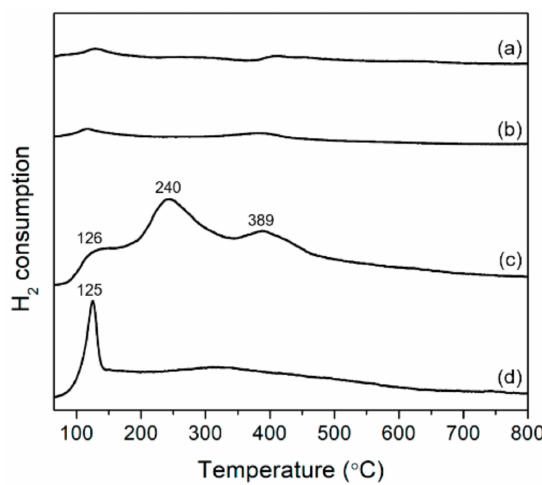
Figure 6. H 2 -TPR profiles of supported Pt-Sn catalysts; ( a ) Pt-Sn/Beta(300), ( b ) Pt-Sn/Beta(38), ( c ) Pt-Sn/ θ -Al 2 O 3 , and ( d )